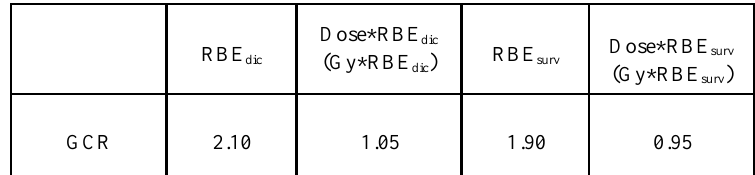
Table 1. RBE values and RBE-weighted doses for lymphocyte dicentrics (RBE dic and Dose*RBE dic ) and for HSF cell death (RBE surv and Dose*RBE surv ) induced by GCR at solar minimum for a total absorbed dose of 0.5